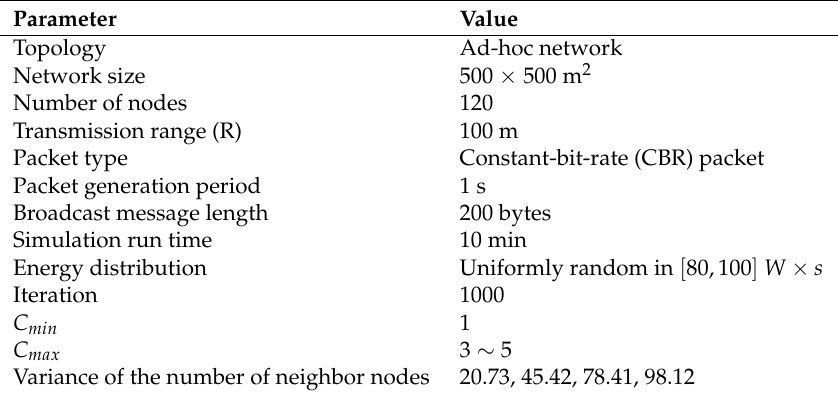
Table 1. Simulation